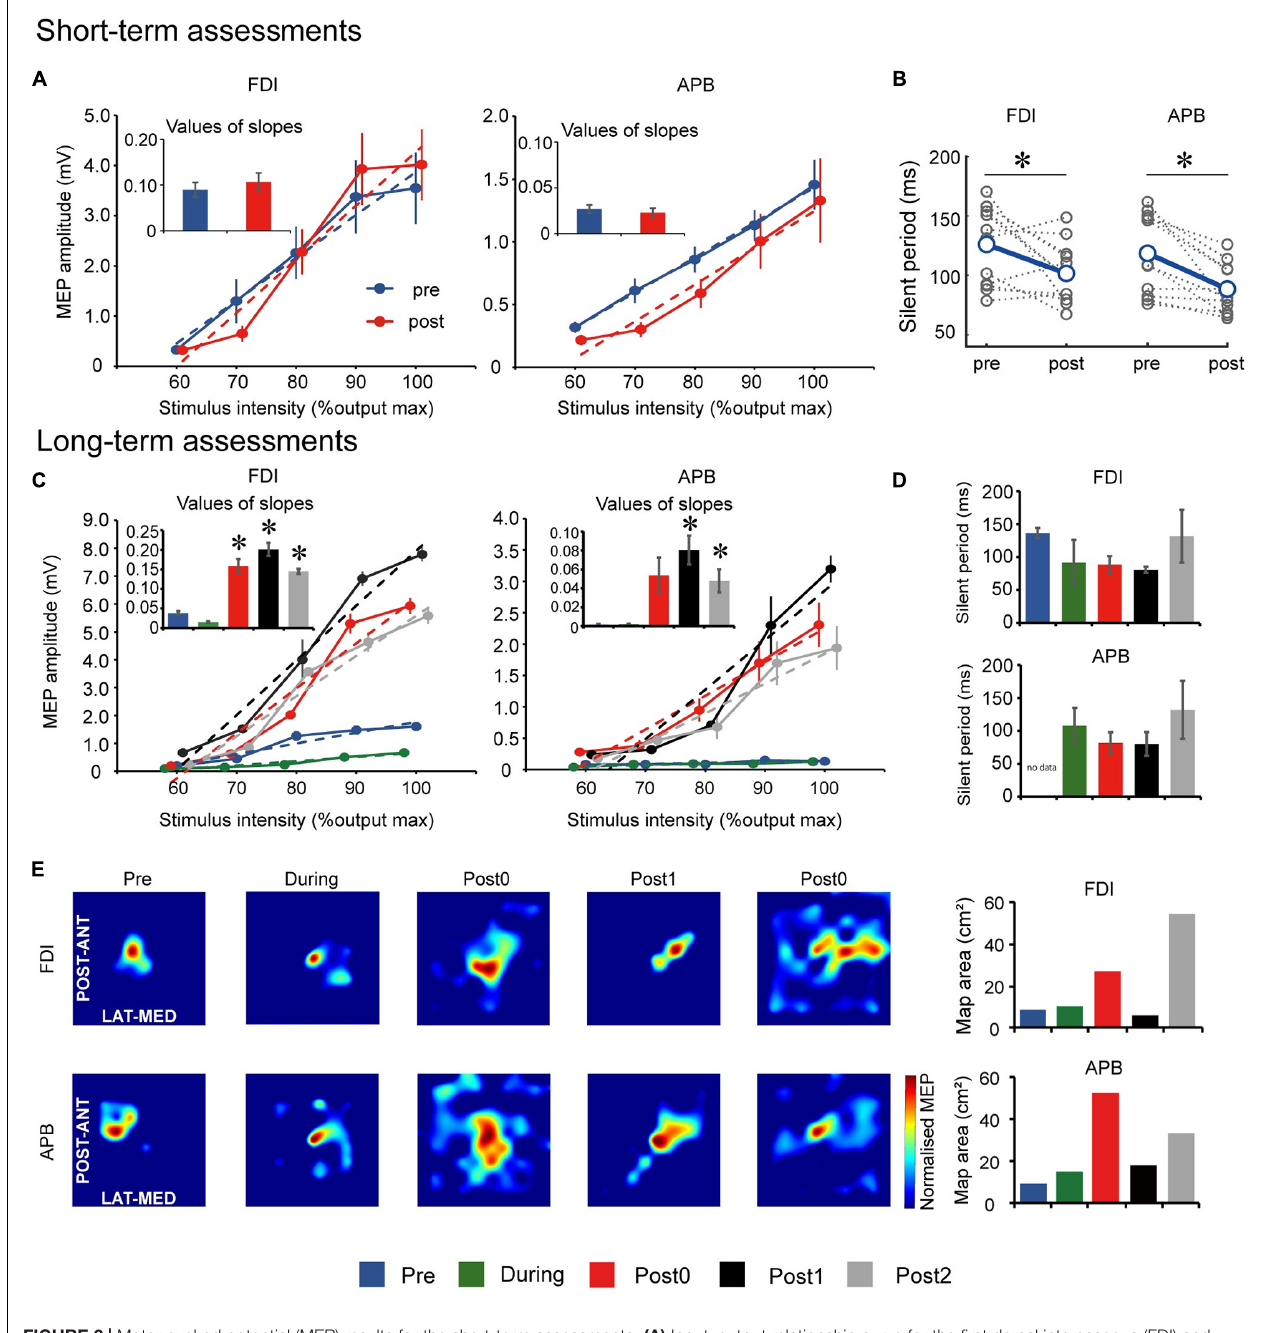
FIGURE 2 | Motor evoked potential (MEP) results for the short-term assessments. (A) Input–output relationship curve for the first dorsal interosseous (FDI) and abductor pollicis brevis (APB) muscles. Dotted lines indicate simple linear regression lines of the curves before and after one FEST session. Bar graphs indicate values of regression line slope and standard error. (B) Cortical silent period (CSP) for the FDI and APB muscles before and after one FEST session. Gray dotted lines indicate data of each day. MEP results for the long-term assessments. (C) Input–output relationship curve for the FDI and APB muscles. Dotted lines indicate simple linear regression lines of the curves at baseline (Pre), after 6- and 12-weeks of FEST (During and Post0) as we as during follow-up assessments 6- and 12-weeks after FEST (Post1 and Post2). Bar graphs indicate values of regression line slope and standard error. (D) CSP for the FDI and APB muscles during Pre, During, Post0, Post1, and Post2 assessments. Bar graphs indicate values of regression line slope and standard error. (E) MEP maps before and after FEST for the FDI and APB muscles. The size of the MEP activated is approximated by the heatmap color scale, which denotes amplitudes normalized to the maximum value in assessment. Bar graphs indicate the calculated area of the MEP map. * p <